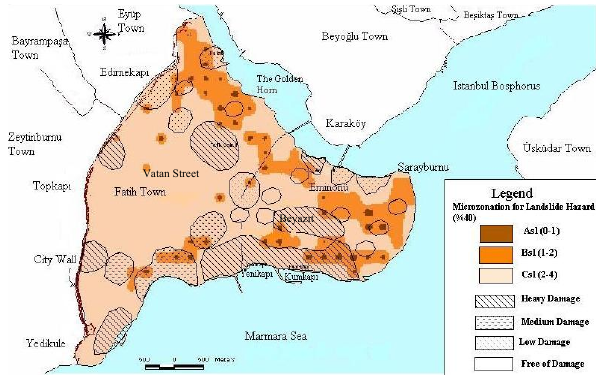
Figure 10. Regional Damage Map of 1894 Earthquake (Lav, 1994). Fig. 10. Regional Damage Map of the 1894 earthquake (Lav, 1994).